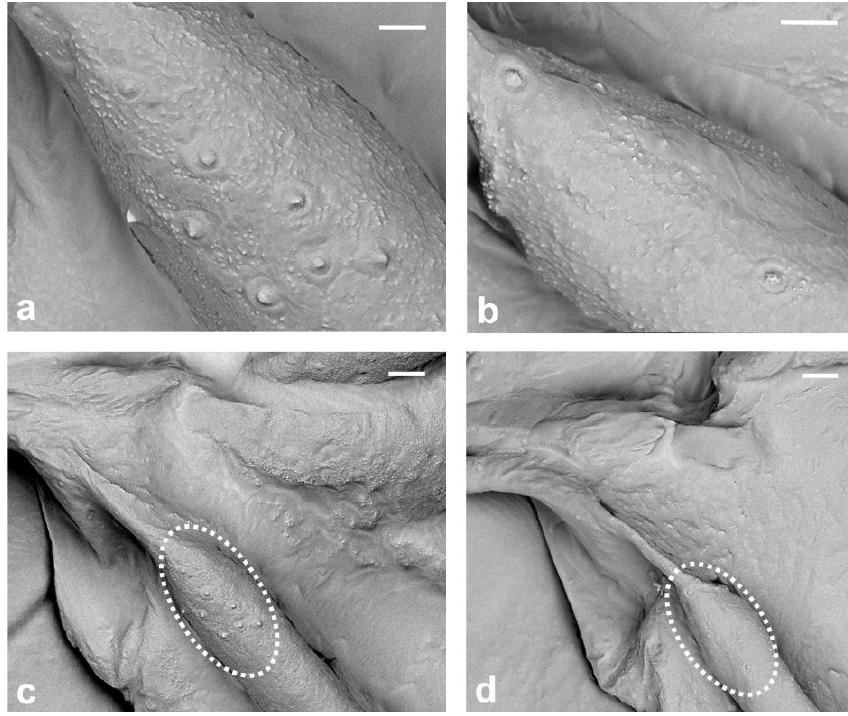
Figure 7. Campaniform sensilla on the wings: ( a ) dorsally; ( b ) ventrally; ( c , d ) location of the CS in white dotted circles. Scale bar ( a , b ) 5 μm and ( c , d ) 10 μm.